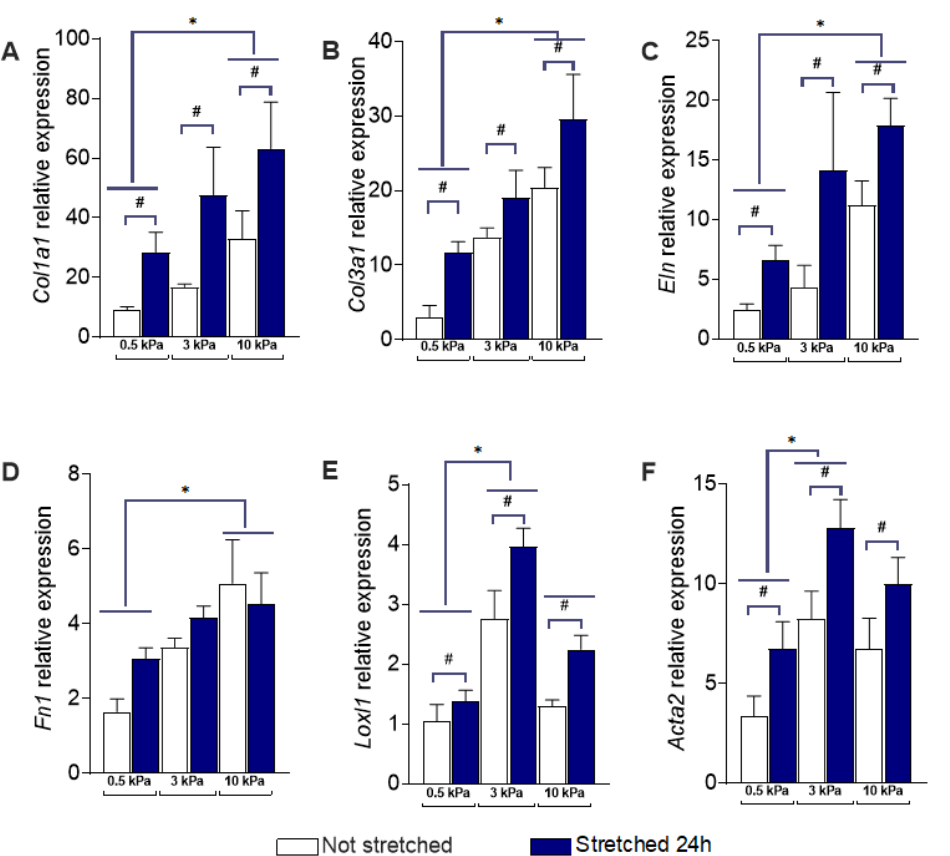
Figure 4. Effect of stiffness and stretch on gene expression in pulmonary arterial adventitial fibroblasts (PAAFs). Mean ± standard errors of the mean of mRNA levels relative to housekeeping control gene 18S ribosomal RNA in unstretched cells ( n = 9, white bars) and after 24 h 10% equibiaxial stretch ( n = 12, blue bars). * Significant pairwise effect of stiffness ( p < 0.05) by a post-hoc Dunnett’s multiple comparisons test and # significant effect of stretch ( p < 0.05) based on group comparisons made using a two-way analysis of variance (ANOVA) for: ( A ) Collagen I ( Col1a1 ) ( B ) Collagen III ( Col3a1 ) ( C ) Elastin ( Eln ) ( D ) Fibronectin ( Fn1 ) ( E ) Lysyl oxidase-like 1 ( Loxl1 ) ( F ) Smooth Muscle Actin ( Acta2 ). Table 1. Calculated p -values from two-way analysis of variance (ANOVA) of the effects of substrate stiffness and stretch on the expression of six genes in cultured pulmonary arterial adventitial fibroblasts (PAAFs). Bolded values indicate p < 0.05. Genes Effects of